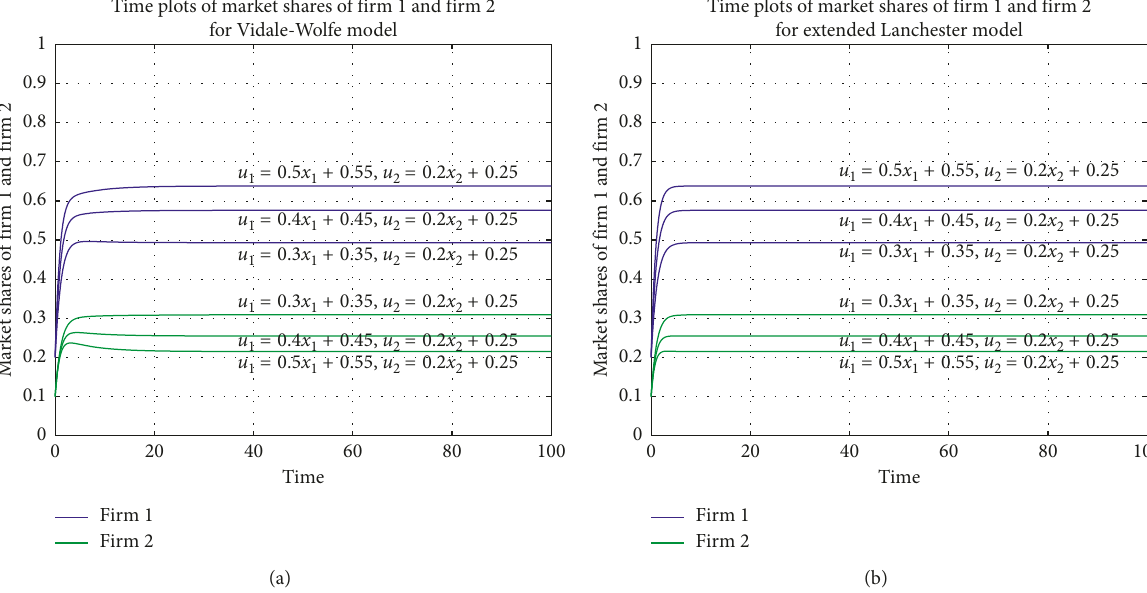
and x under affine advertising policies for (a) Vidale–Wolfe model expressed in equation 1 2